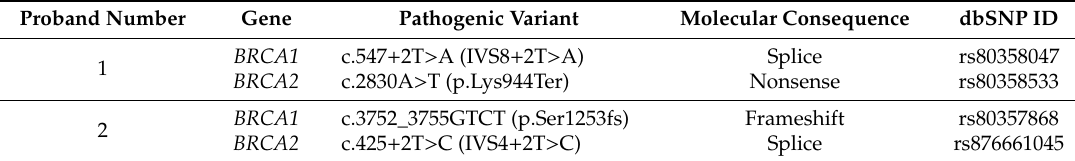
Table 1. Probands with double heterozygosity (DH) in the BRCA1 / 2 genes.